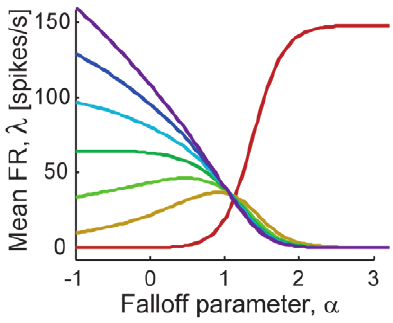
Figure 5. Hypothetical response curves as functions of a with model that takes into account gain control within hypercol- umn. The seven representative neurons in the foveal condition, in which the neuronal distribution is estimated as shown in Fig. 4d (brown histogram). The most-preferred frequencies of sampled neurons are spaced evenly from 0.01 to 10 cycles/deg (colored from red to indigo).